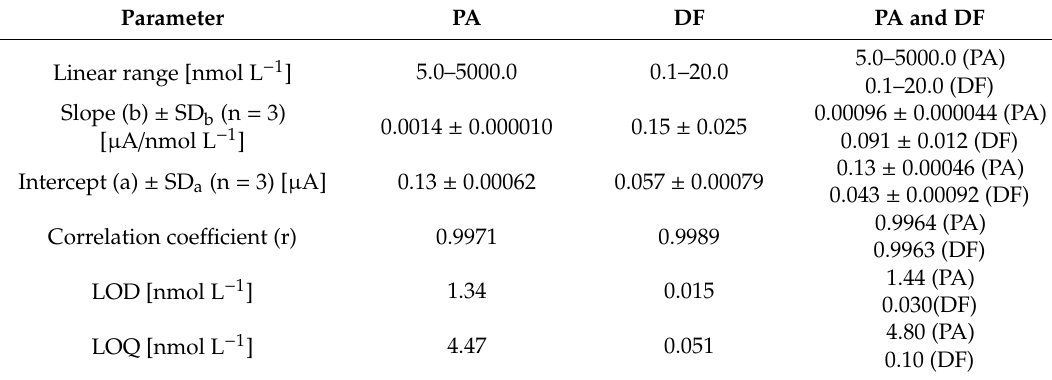
Table 1. Characteristics of calibration plots of paracetamol (PA) and diclofenac (DF) attained at the commercially available carboxyl functionalized multiwalled carbon nanotubes modified screen-printed carbon electrodes (SPCE / MWCNTs-COOH). LOD, limit of detection; LOQ, limit of quantification.